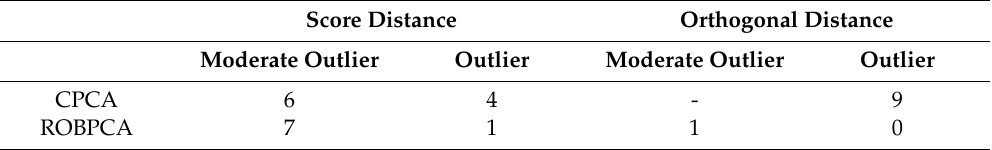
Figure 11. A classical principal components’ analysis (CPCA) was performed on the final feature matrix in JMP® . As with ROBPCA, 21 principal components were used for analysis. The Hotelling T 2 test ( A ) and normalized DModX plot ( B ) were implemented in this software for multivariate outlier detection. The Hotelling T 2 plot is used to identify outlying batches in the score direction, if a batch exceeds the red line, representing the 95% confidence interval (CI) of the model population, the batch can be assumed to be an outlier, whereas batches above the green line (median of the model population) can be considered as moderate outlier. The DModX plot is used to identify outlying batches in the orthogonal direction, if a batch exceeds the red line, representing the 95% CI of the model population, the batch can be assumed to be a moderate outlier. Outliers in both tests are marked as red circles. Table 3. Comparison of CPCA and ROBPCA in terms of outlier identification.